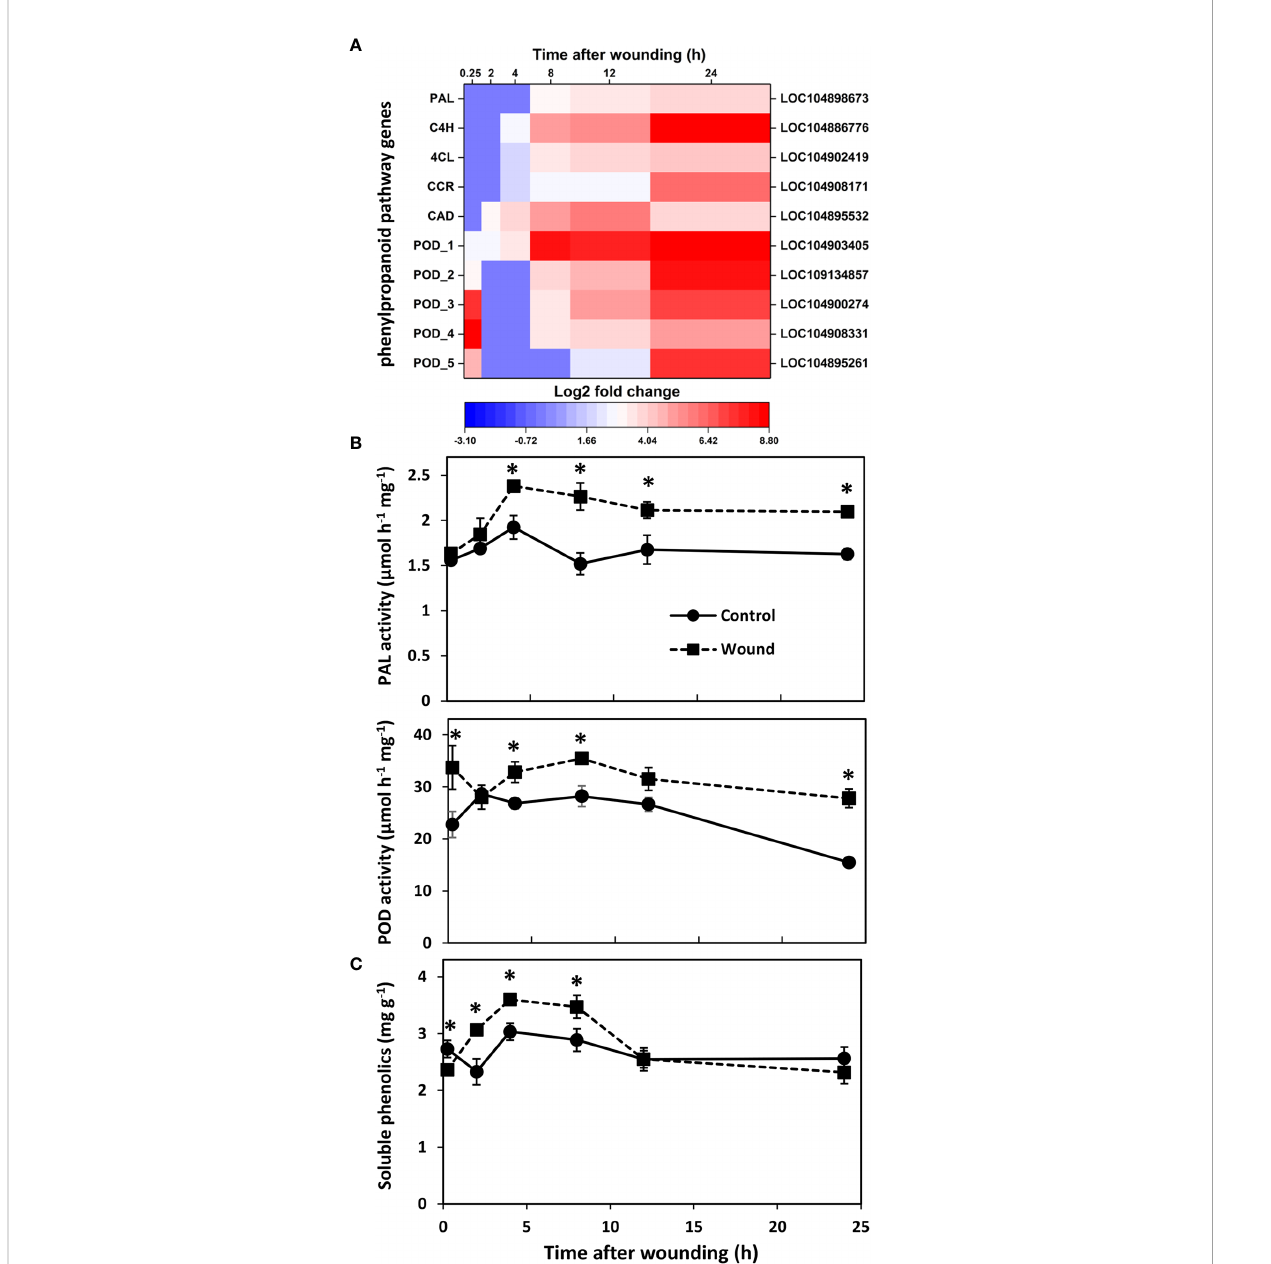
FIGURE 6 Changes in (A) differential expression of genes involved in the production or polymerization of phenolic substrates for suberin and lignin formation, (B) PAL and POD enzyme activities, and (C) soluble phenolics concentration with respect to time after wounding. Heat map displays the log 2 fold change in gene expression between wounded and control roots at 0.25, 2, 4, 8, 12 and 24 h after wounding for all pathway genes that exhibited a log 2 fold change in expression ≥ |1| at any time point after wounding. Enzyme activities are expressed per mg protein; soluble phenolics concentration is expressed as mg gallic acid per g dry weight. PAL, phenylalanine ammonia-lyase; C4H, trans-cinnamate 4- monooxygenase; 4CL, 4-coumarate:coenzyme A (CoA) ligase; CCR, cinnamoyl-CoA reductase; CAD, cinnamyl alcohol dehydrogenase; POD, peroxidase. For all analyses, n = 4. Error bars are SE of the mean. * denotes time points for which values for wounded and control roots differed signi fi cantly (p ≤